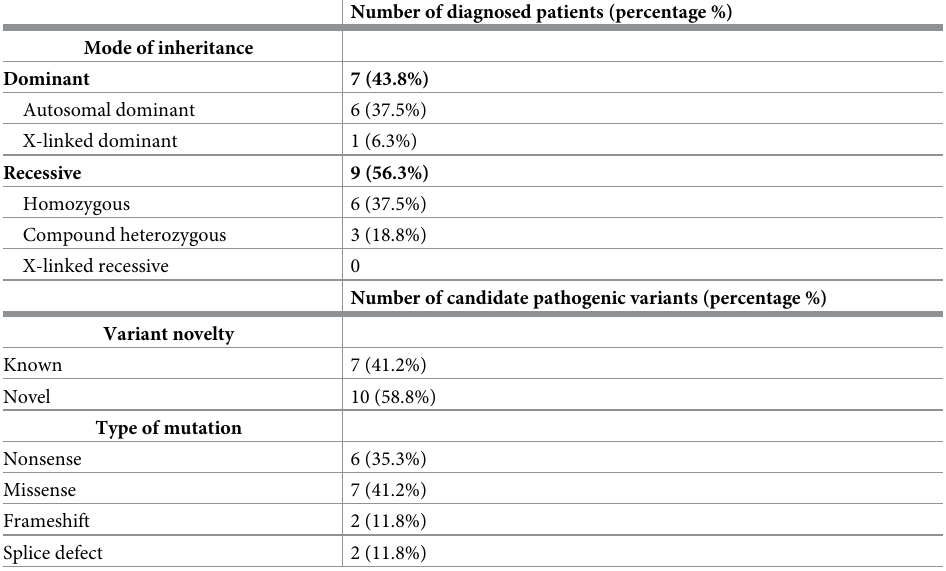
Table 2. Distribution of Mendelian mode of inheritance, novelty of variants and variant type of index cases with a molecular